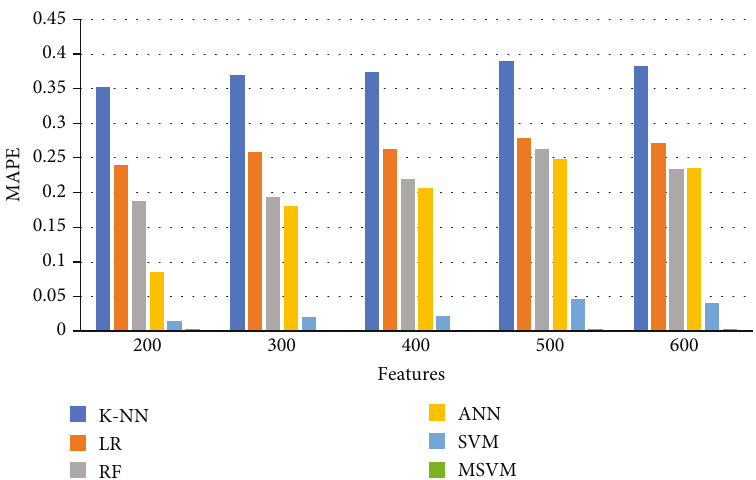
Figure 5: Mean average percentage error